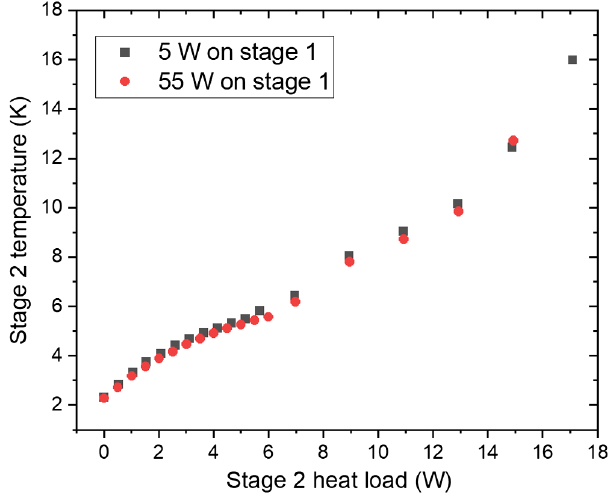
FIG. 3. Stage 2 temperature as a function of the stage 2 heat load for two different stage 1 heat load values for a GM cryocooler model RDE418-D4 measured at Jefferson